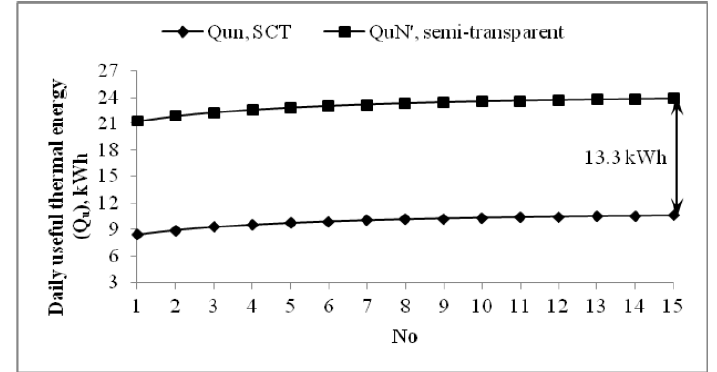
Figure 6. Variation of thermal energy w.r.t number of air